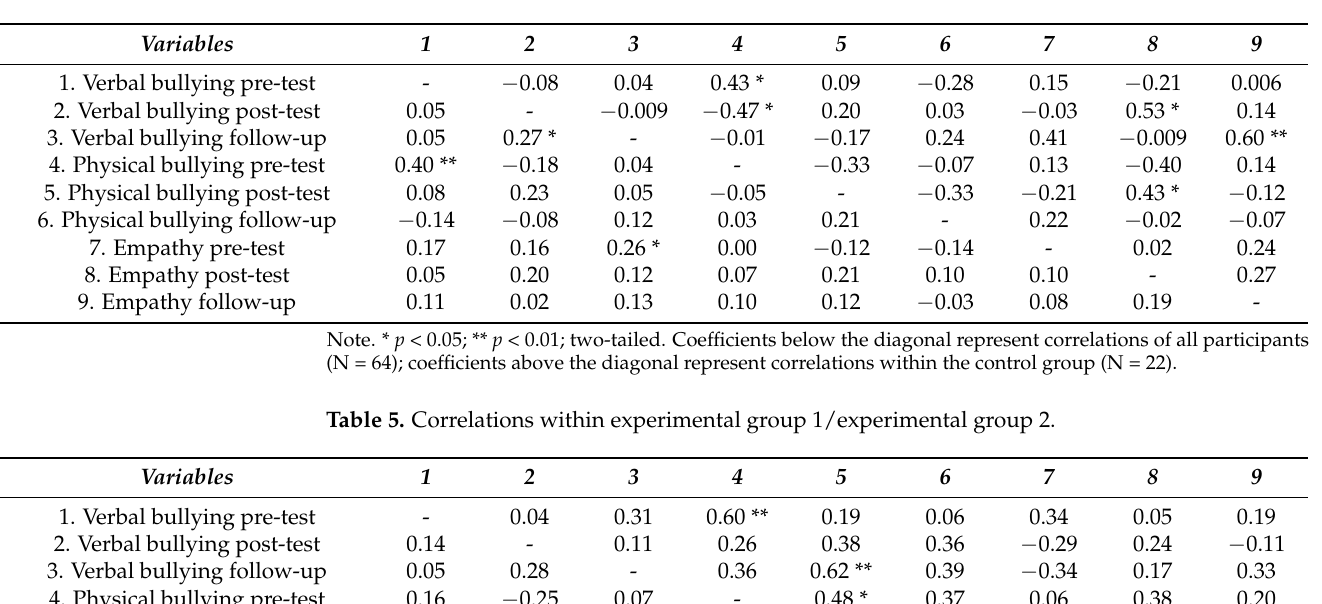
Table 4. Correlations with all participants included/within the control group.